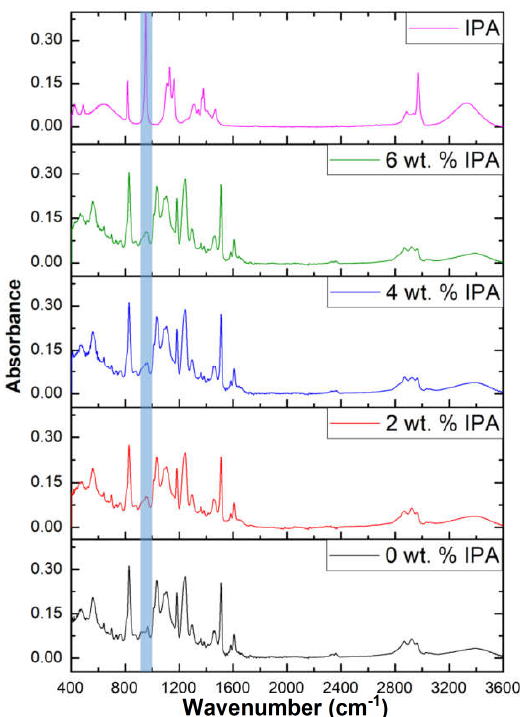
Figure 3. FTIR spectra for IPA and for cured adhesive samples containing 0, 2, 4, 6 wt.% IPA.